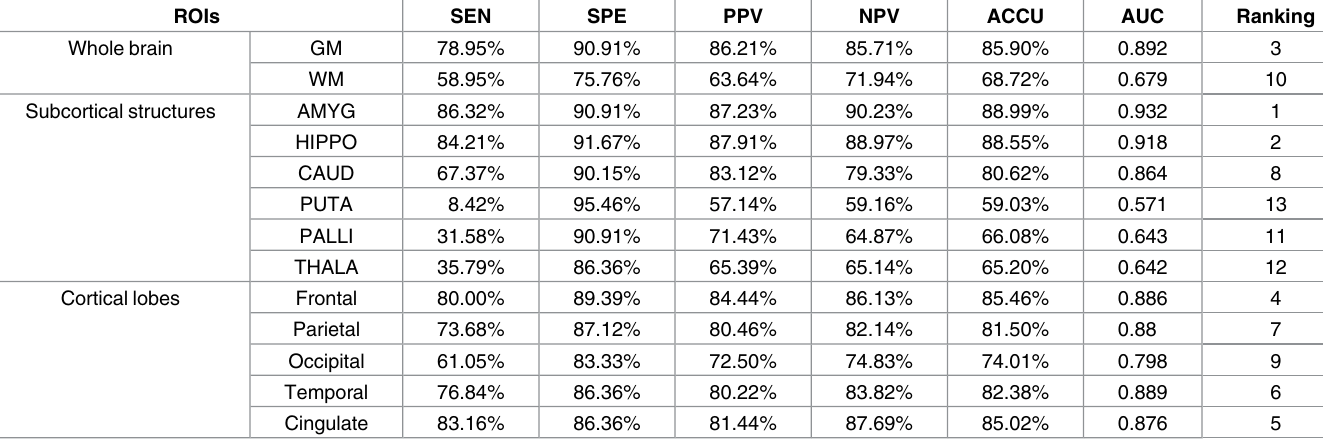
SEN: sensitivity; SPE: specificity; PPV: positive predictive value; NPV: negative predictive value; ACCU: accuracy; AUC: area under ROC curve. GM: whole-braingray matter; WM: whole-brainwhite matter; AMYG: amygdala; HIPPO: hippocampus; CAUD: caudate; PUTA: putamen; PALLI: globus pallidus; THALA: thalamus.